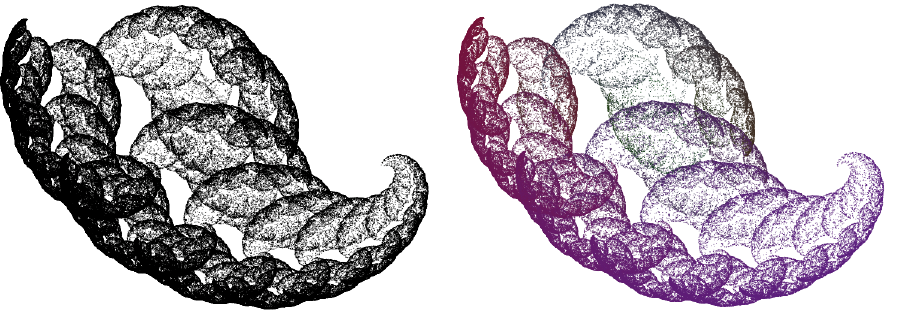
Figure 3. Fractal image used in this paper: ( left ) in black and white; ( right ) in different colors for each contractive